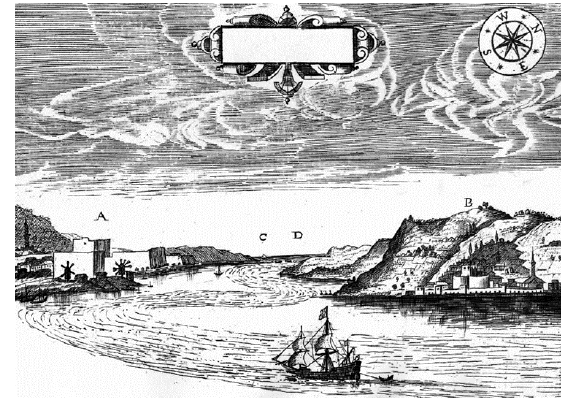
Figure 03 : Gravure 02: George Sandys' Gravure dated 1621 (Ministry of Culture and Tourism - Anatolian Gravure Album)